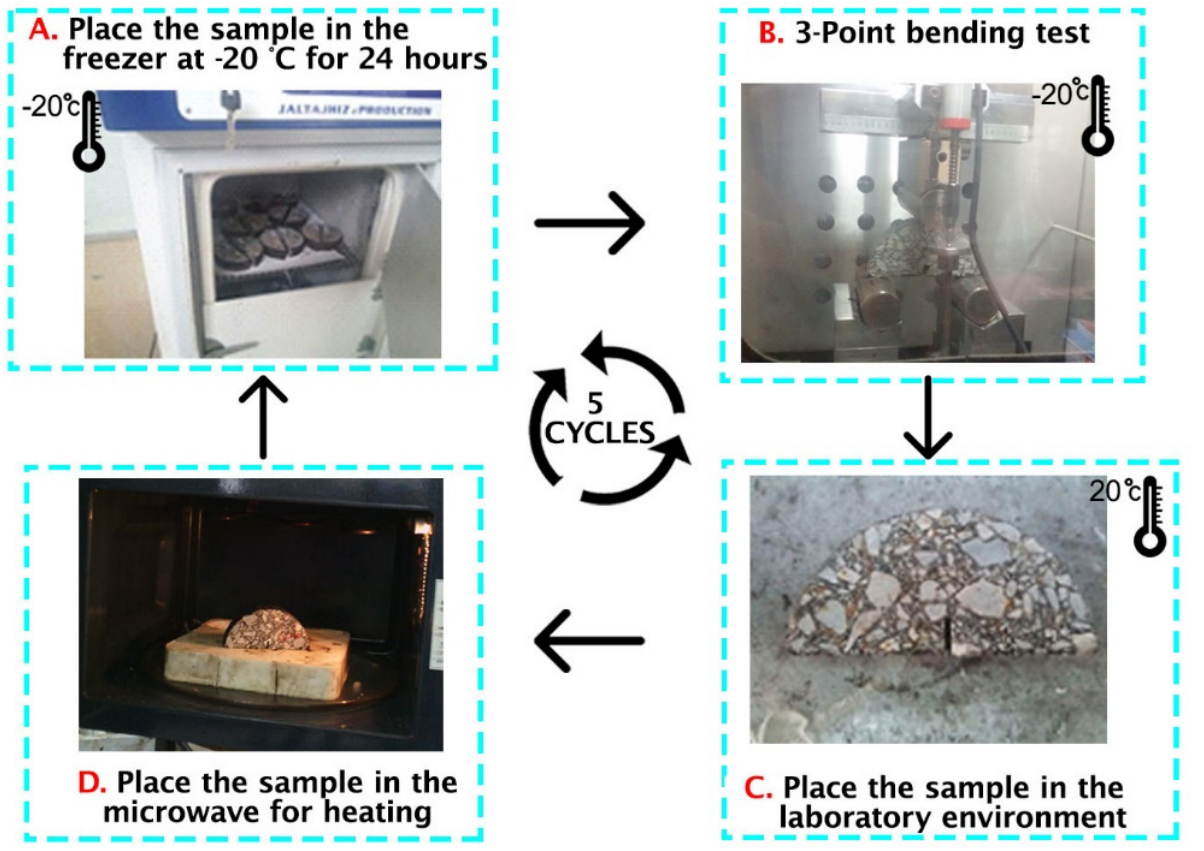
Figure 4. Steps involved in microwave